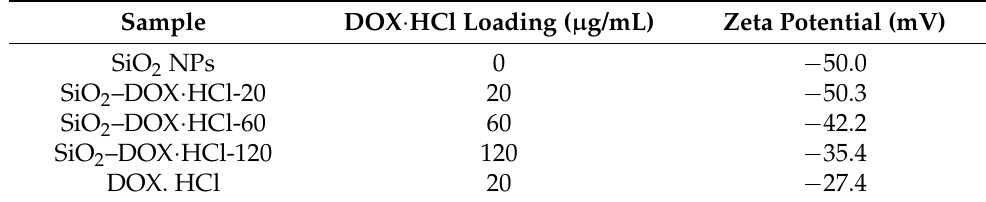
Table 1. Zeta potential values of bare SiO 2 NPs and different quantity DOX · HCl absorbed on SiO 2 NPs in an aqueous solution.